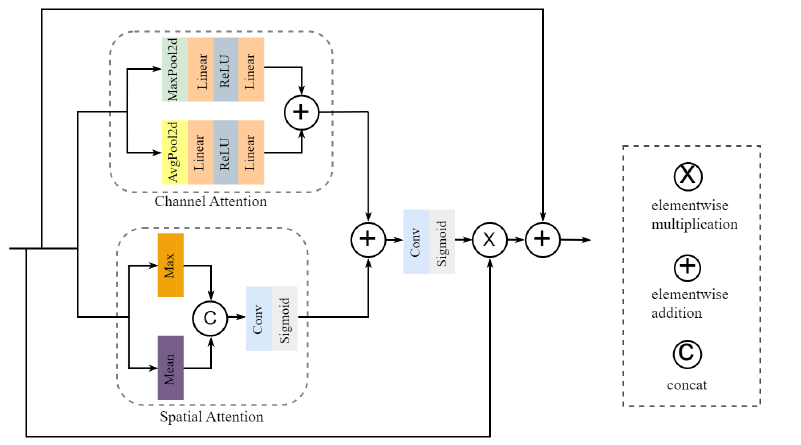
Figure 4. Efficient spatial-channel attention